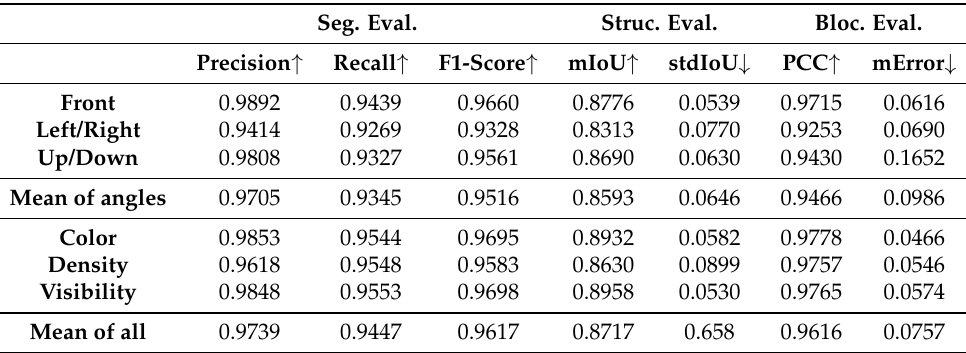
Table 2. Quantitative evaluation results on the VFN